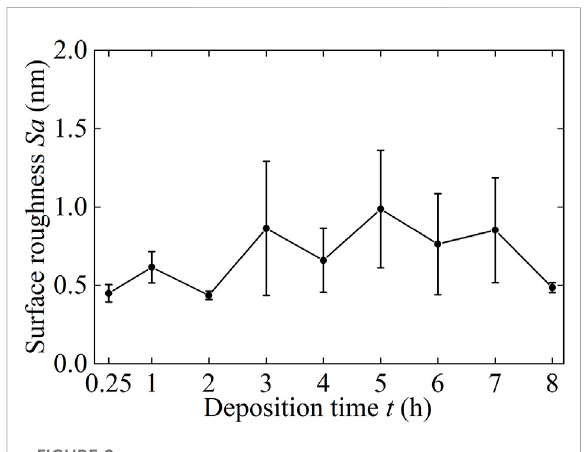
FIGURE 2 Surface roughness S a of DLC fi lms with deposition time.